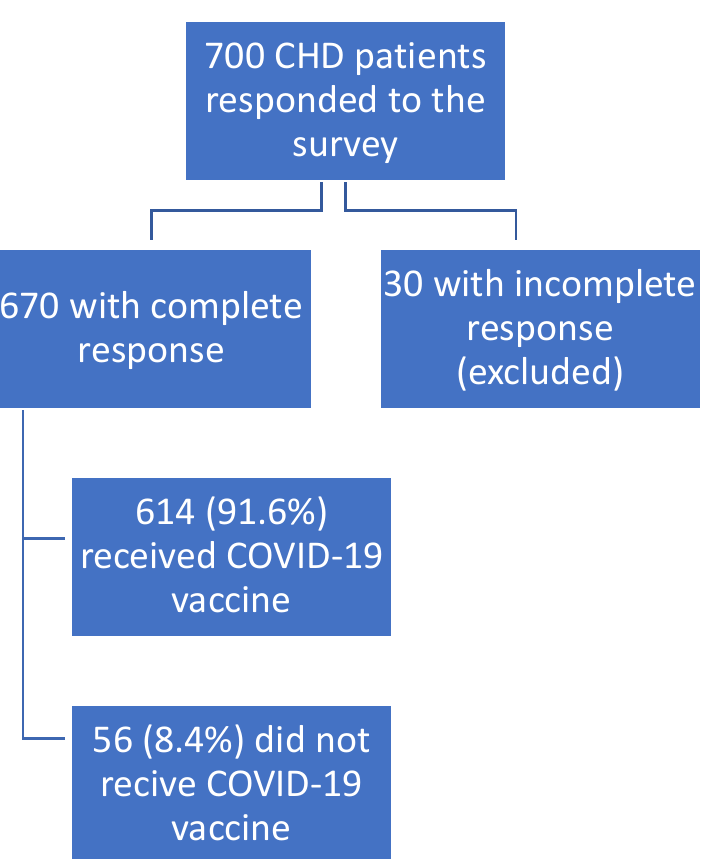
Figure 1. Classification of the survey responses from patients on chronic hemodialysis (CHD). The mean age of the study participants was 50.79 (SD = 15.9) years. More than half of the patients (58.1%) were females and most of them were married (78.1%). Three hundred and eighty-seven (57.8%) patients were illiterate, 416 (62.1%) were from urban areas, 540 (80.6%) were non-smokers and 417 (62.2%) had an average socioeconomic status. The median duration of HD was 5 years. In terms of comorbidities, 430 (64.2%) patients were hypertensive, 64 (9.6%) were diabetic, and 178 (26.6%) had chronic anemia, as illustrated